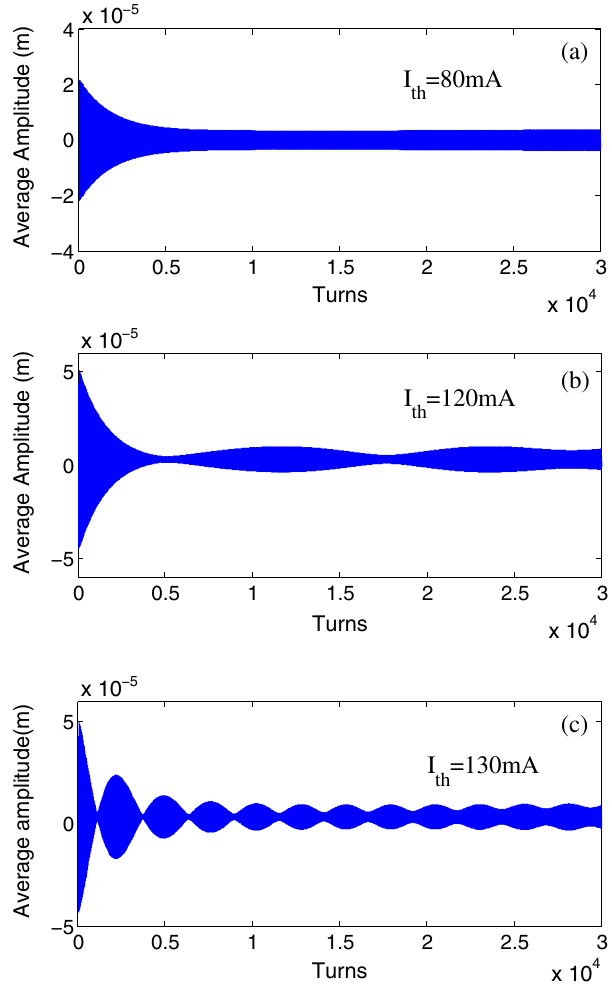
FIG. 3. Tracking results showing the resistive wall instability for three different cases. (a) average beam oscillation ampli- tude of two bunch trains on the golden orbit; (b) average amplitude of two bunch trains with 200 μ rad separation; (c) aver- age amplitude of two bunch trains with 400 μ rad separation. The amplitude approaching a constant value indicates that an instability threshold has been